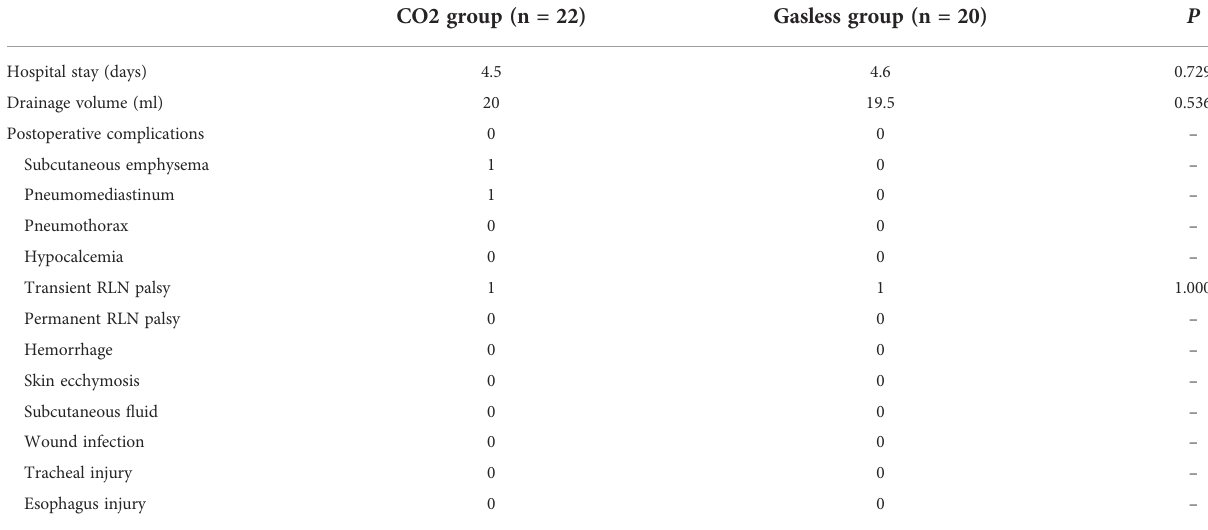
TABLE 4 Post-operative outcomes of the two groups.